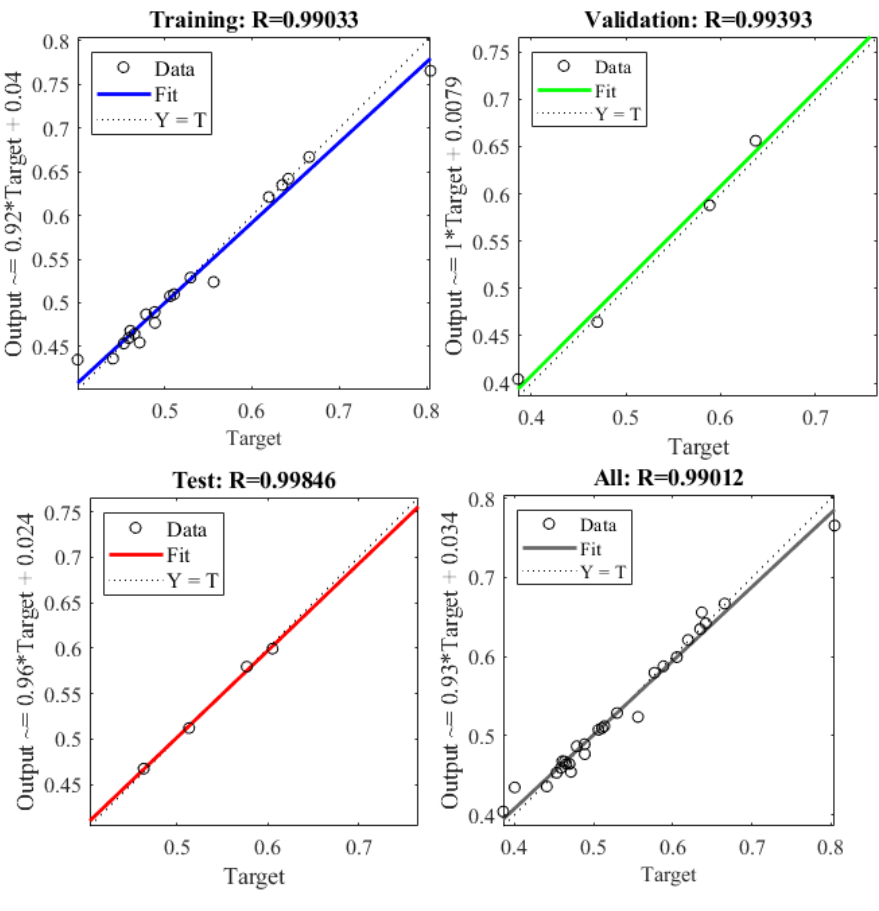
Figure 8. Statistical analysis of GRG.